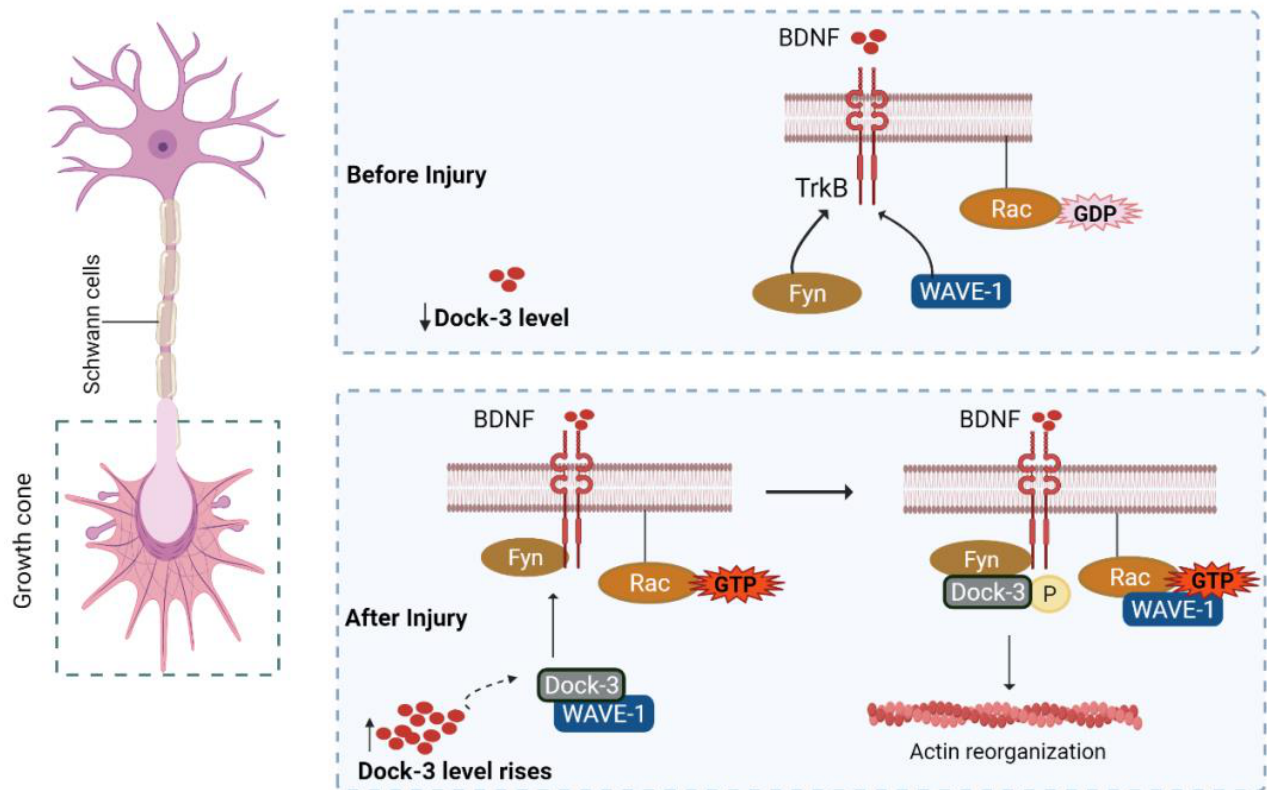
Figure 5. Dock-mediated BDNF signaling. Upon injury, Dock-3 expression increases at the injury site that recruits WAVE-1 to form a complex with Fyn. This complex interacts with Trk-B receptors to modulate Rac-GDP to Rac-GTP and mediates actin organization for axonal growth. BDNF: brain-derived neurotrophic factor; TrkB: tyrosine kinase receptor; GDP: guanosine diphosphate; GTP: guanosine triphosphate; Dock3/Rac/Fyn/WAVE-1: protein.